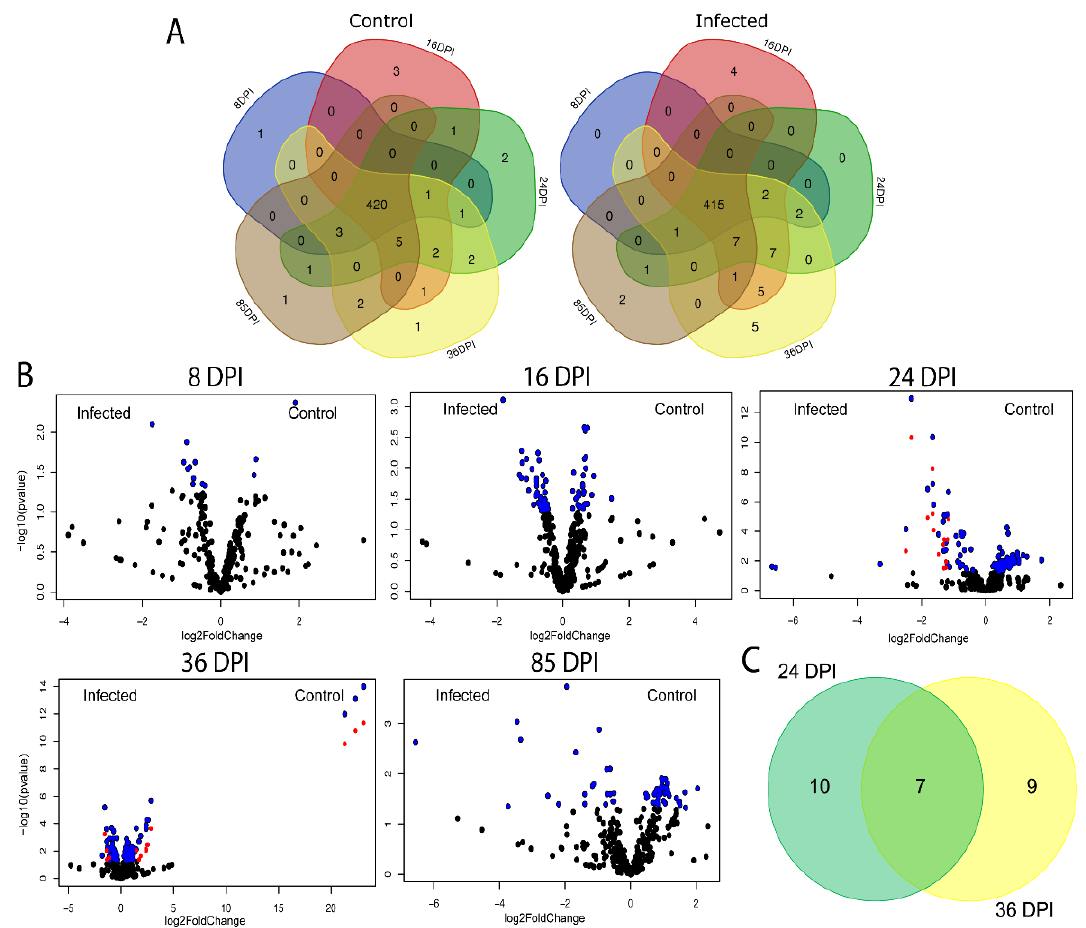
Figure 7. Impact of P. homocircumflexum infection on the predicted functional profiles of bird gut microbiome. ( A ) Venn diagram showing the common and different predicted bacterial pathways found in the microbiome of birds infected with P. homocircumflexum and uninfected birds at different sampling days. ( B ) Volcano plot showing differential pathway abundance in Plasmodium- infected and uninfected birds detected by DESeq2 analysis at 8, 16, 24, 35 and 85 DPI. The blued dots indicate all statistically significant ( p (un-adjusted) < 0.05) pathways, red dots indicate pathways with statistically significant ( p (adjusted) < 0.05) log2 fold changes in the absolute value (cut-off of 1); the black dots are not significant ( p > 0.05). Detailed information on pathway identity is presented in Table S6. ( C ) Venn diagram. Comparison of unique and shared pathways with significant changes in abundance ( p (adjusted) < 0.05) between the Plasmodium -infected and uninfected groups at 24 and 36 DPI. Only pathways with statistically significant log2 fold changes in the absolute value (cut-off of 1) were